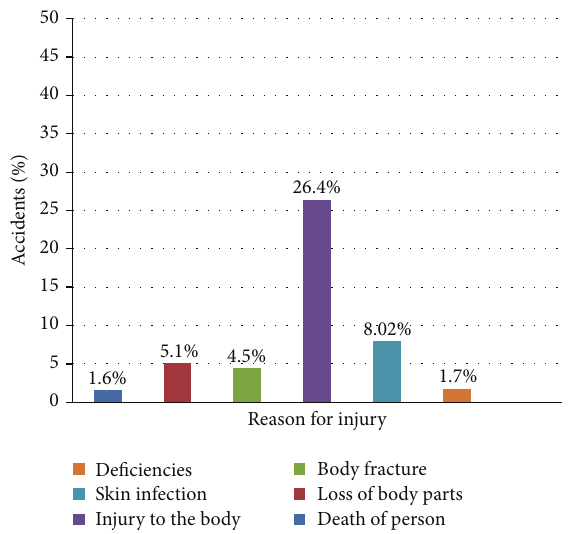
Figure 3: Percentage of accidents in large construction sites.